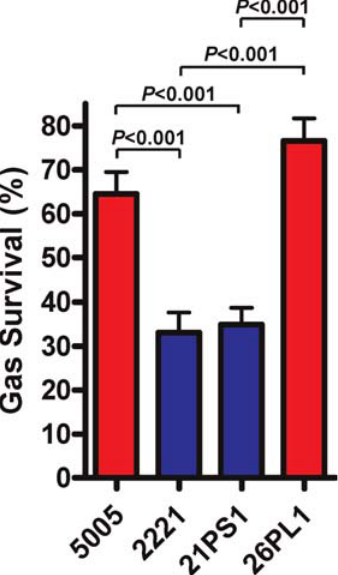
Figure 4. ITP and PTP GAS Show Differential Resistance to PMN- Mediated Killing Killing of ITP GAS strains MGAS5005 and 26PL1 by human PMNs occurred at significantly lower levels than the PTP GAS strains MGAS2221 and 21PS1 ( p , 0.001, analysis of variance with Bonferroni’s posttest for multiple comparisons). Results shown are the mean 6 standard error of the mean of four experiments. DOI: 10.1371/journal.ppat.0020005.g004